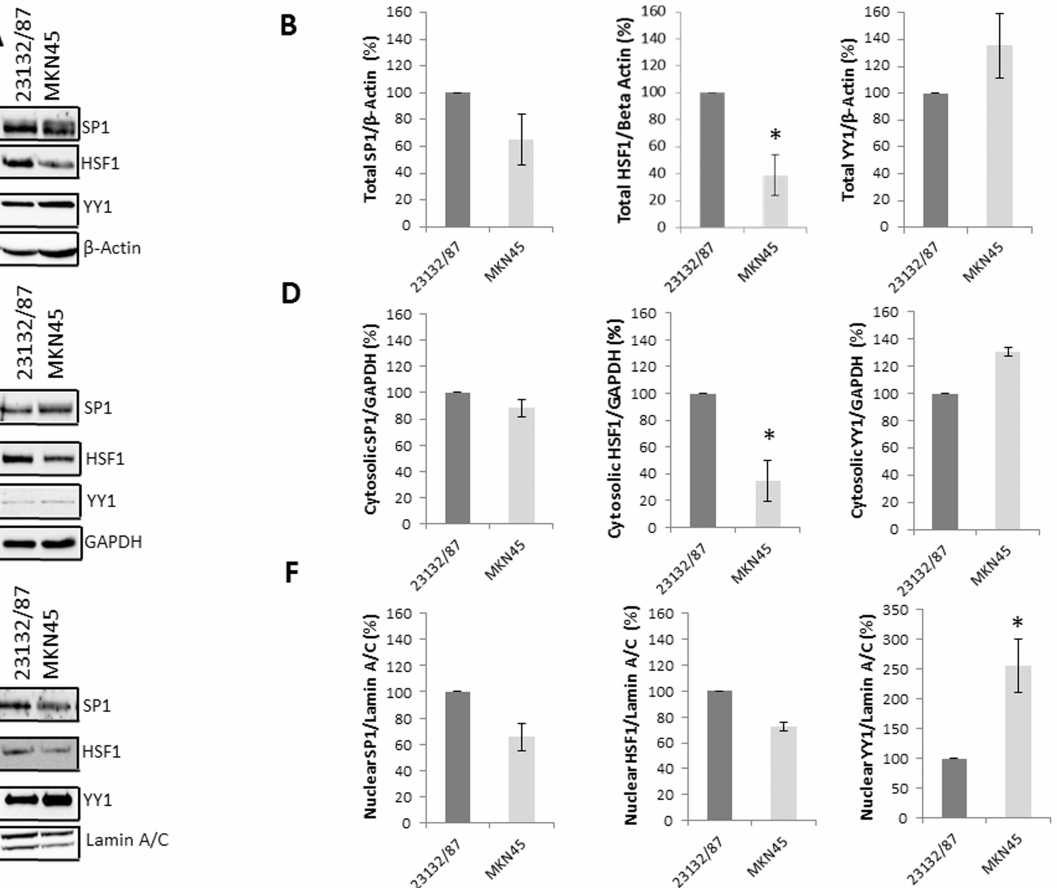
Figure 2. Analysis of total, cytosolic and nuclear levels of transcription factors SP1, HSF1 and YY1 in 23132 / 87 and MKN45 cell lines. Representative western immunoblots ( n = 3) performed using total ( A ), cytosolic ( C ) and nuclear ( E ) lysates, which were obtained from 23132 / 87 and MKN45 cells. Quantities of 15 µ g of total or cytosolic cellular proteins and 7.5 µ g of nuclear proteins were loaded and probed with antibodies specific for SP1, HSF1 and YY1. Blots were reprobed with antibodies against proteins used as a loading control: anti- β -Actin for total extracts, anti-GAPDH for cytosolic extracts and anti-Lamin A / C for nuclear extracts. Quantification ( B , D , F ) of SP1, HSF1 and YY1 levels in 23132 / 87 and MKN45 samples was performed with Image Lab analysis software version 5.2.1. The values obtained from the ratio between SP1, HSF1 and YY1 signals and the loading control β -Actin ( B ) or GAPDH ( D ) or Lamin A / C ( F ) in MKN45 cells were calculated and compared with the values obtained in 23132 / 87 cells, set as 100%; * p <